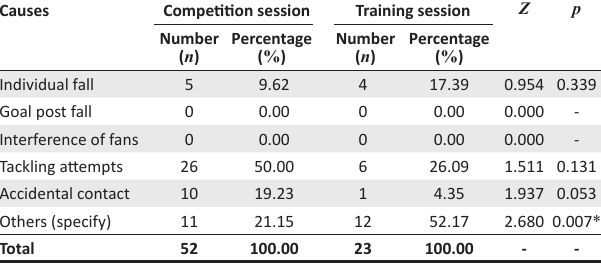
TABLE 3: Causes of injury during competition and training.